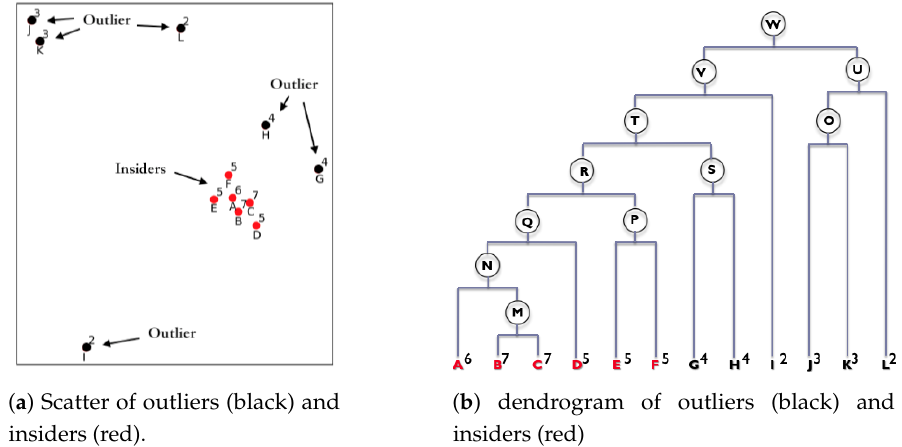
Figure 1. An example of clustering with several outliers: according to the hierarchical clustering result, the participation degrees are marked for each